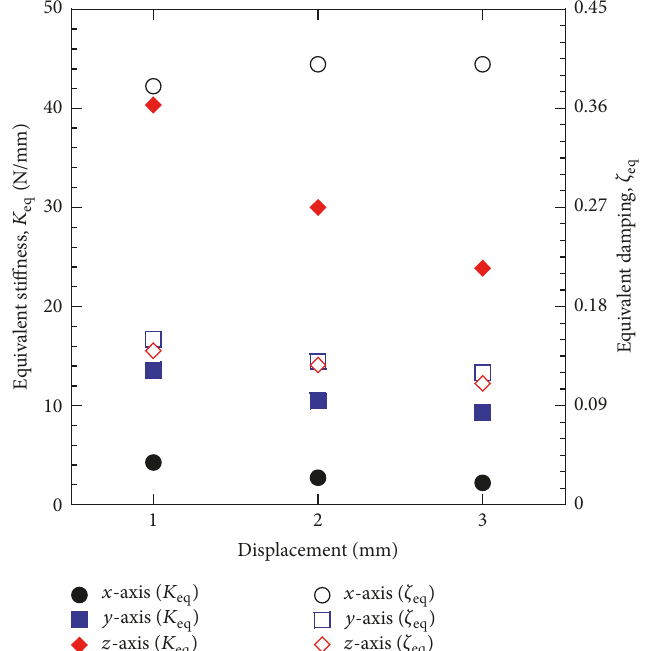
Figure 6: Estimated values of the equivalent stiffness ( 𝐾 eq ) and damping ( 𝜁 eq ) of the isolator on each axis with respect to displacement ranges.